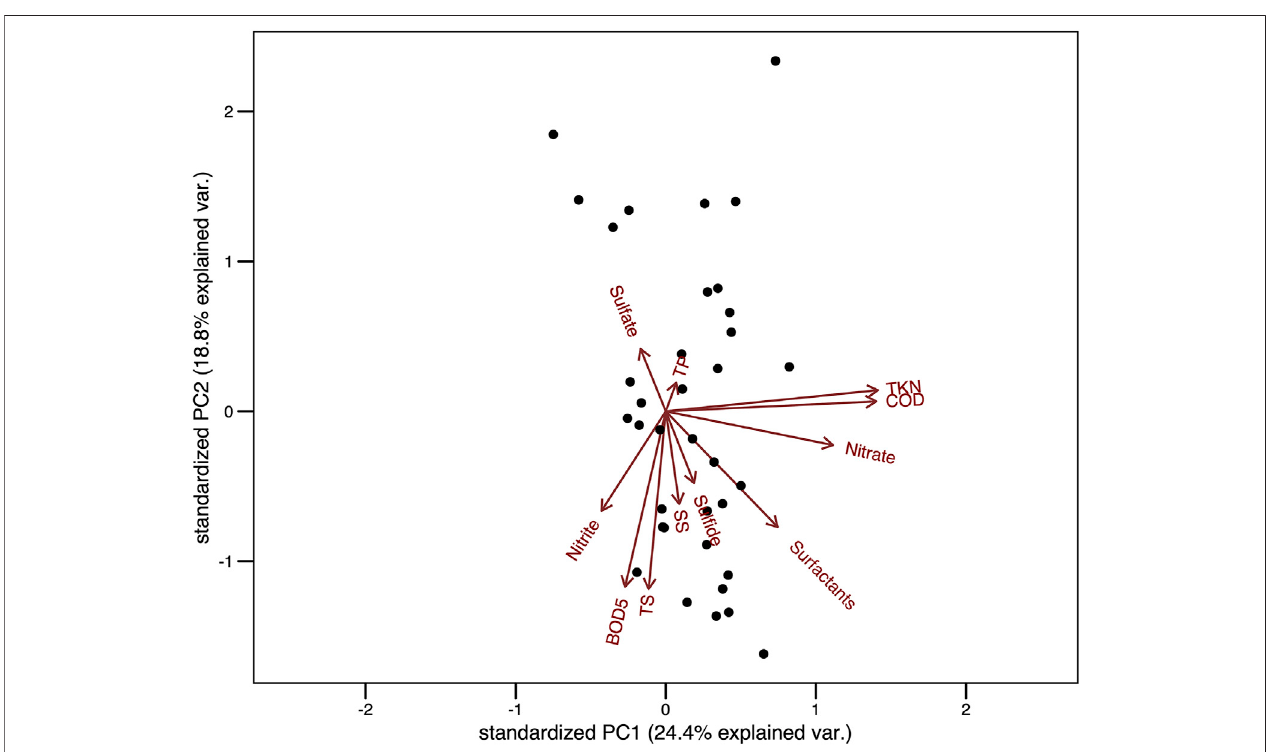
FIGURE 6 | Principal Component Analysis (PCA) about environmental variables recorded throughout 37 samplings in a wastewater treatment plant in Brazil. Legend: TP, total phosphate; TS, total solids ; SS, settleable solids; TKN, total kjeldahl nitrogen; COD, chemical oxygen demand; BOD5, biochemical oxygen demand.